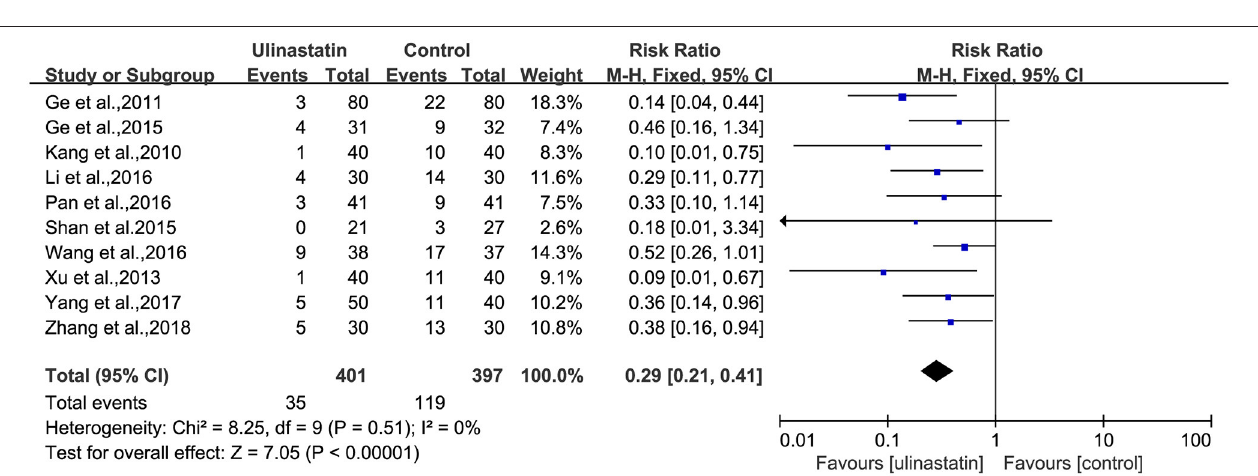
FIGURE 2 | Risk of bias graph: review authors’ judgments about each risk of bias item presented as percentages across all included studies.